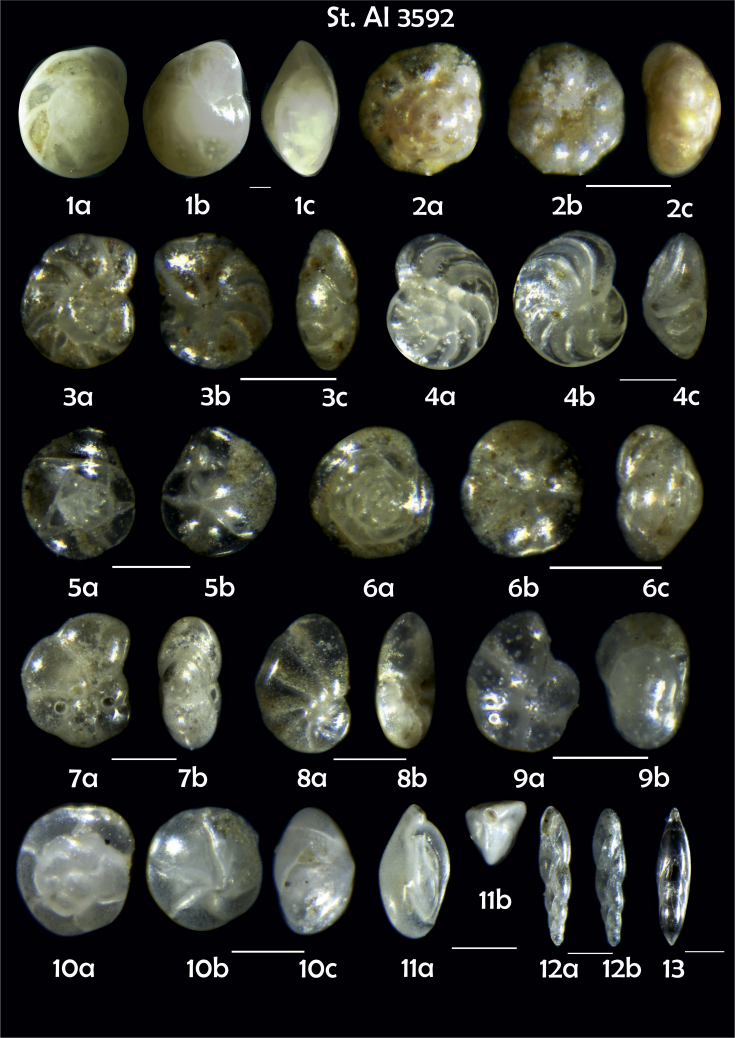
Station 35921Hoeglundina elegans, a spiral view, b umbilical view, c lateral view. 2. Ioanella tumidula, a spiral view, b umbilical view, c lateral view. 3Cibicidoides sp. 4C. wuellerstorfi,a umbilical view, b spiral view, c apertural view. 5Epistominella exigua, a spiral view, b umbilical view. 6Alabaminella weddellensis, a spiral view, b umbilical view, c lateral view. 7Pullenia quinqueloba,a side view, b apertural view. 8. Nonionella auricula, a spiral view, b apertural view 9. Melonis sp. juvenile form?, lake st. 3593 (5), a side view, b apertural view. 10Oridorsalis umbonatus, a spiral view, b umbilical view, c lateral view. 11Triloculina trihedra, a lateral view, b apertural view. 12Fursenkoina complanata, a apertural view, b lateral view. 13Pyrulina sp. Scale 100 μm.